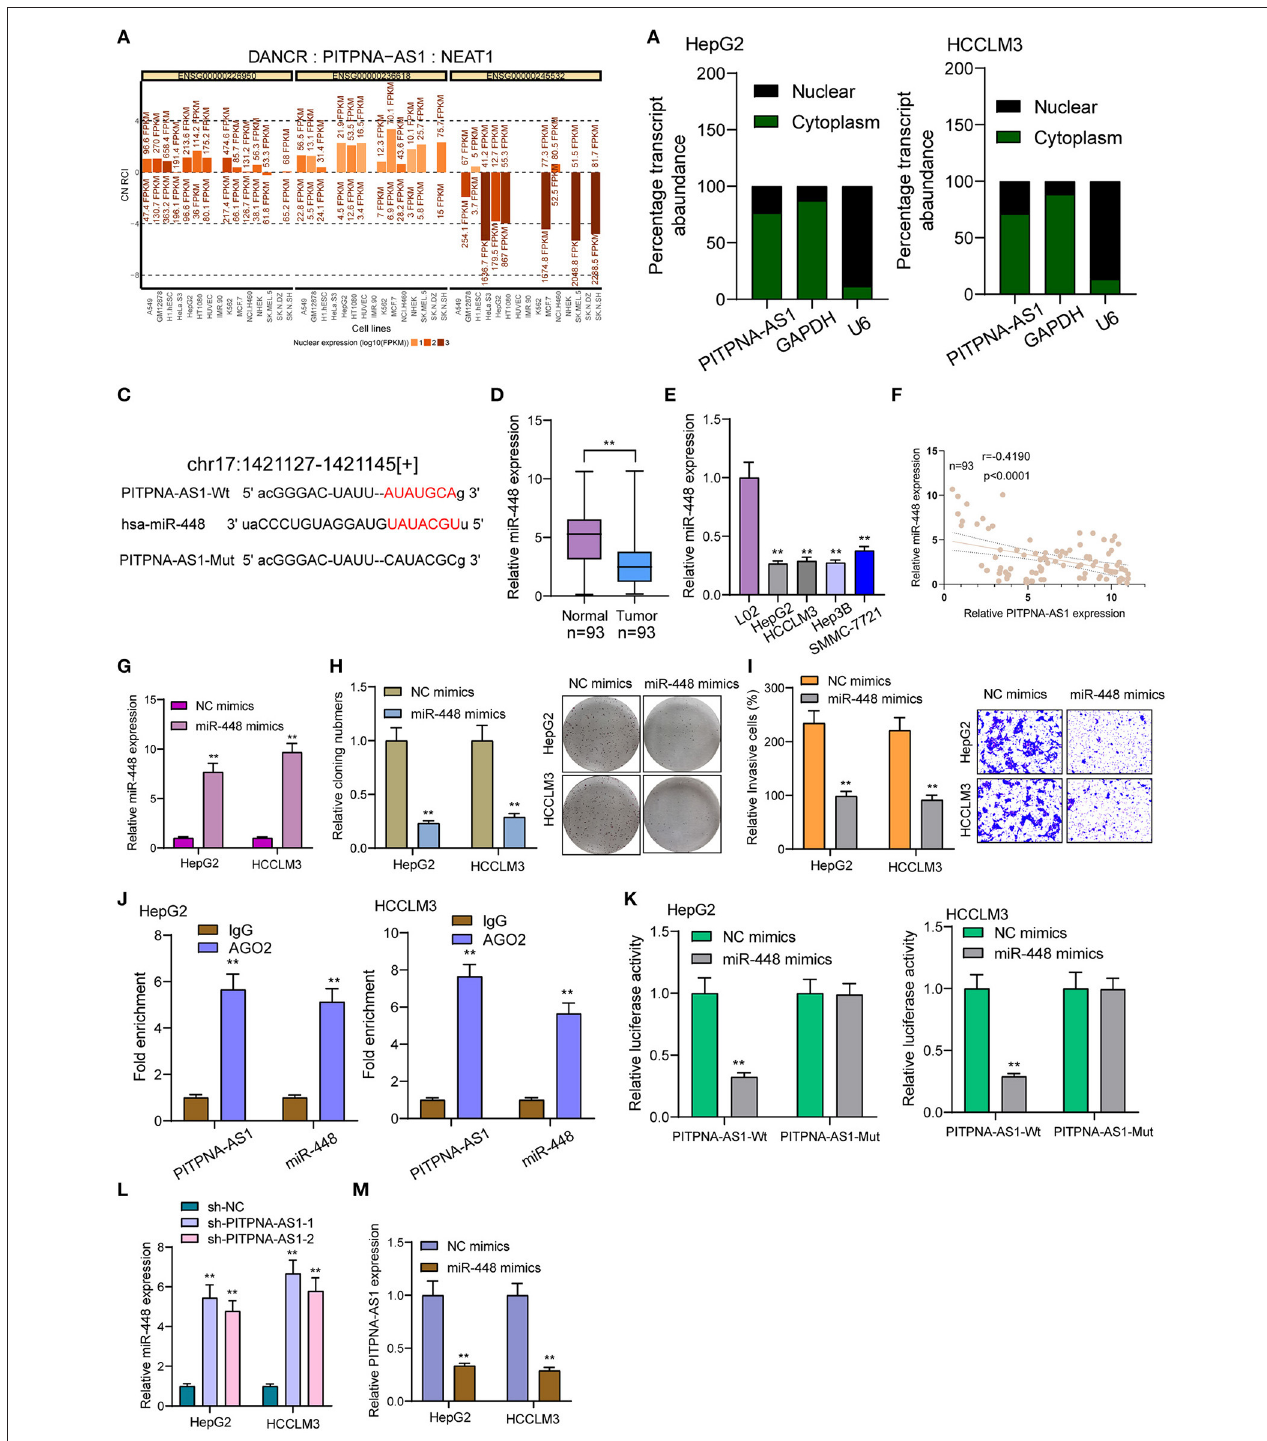
FIGURE 4 | PITPNA-AS1 functioned as a sponge of miR-448. (A) “lncATLAS” showed the subcellular localization of PITPNA-AS1 in a series of tumor cells. (B) Relative PITPNA-AS1 expression levels in nuclear and cytosolic fractions of HepG2 and HCCLM3 cells. (C) Schematic outlining the predicted binding sites between PITPNA-AS1 and miR-448. (D,E) RT-PCR determined the expression of miR-448 in HCC specimens and cell lines. (F) Correlation analysis between PITPNA-AS1 expression and miR-448 expression in 93 HCC specimens. (G) Knockdown of miR-448 in HepG2 and HCCLM3 cells after the transfection of mi-448 mimics. (H) Clone formation assay showed the clone number of HCC cells transfected with miR-448 mimics and NC mimics. (I) Transwell assays were used to determine the